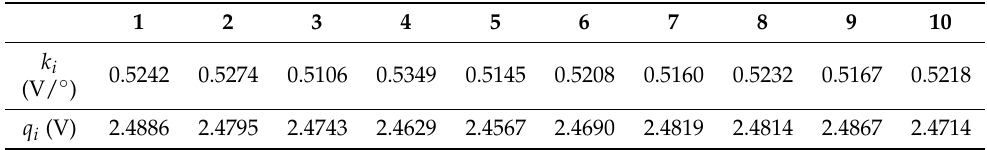
Table 3. Means of k and q parameters for each measurement.